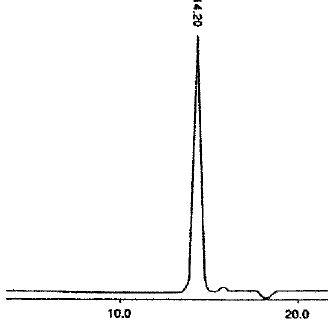
FIG. 3. HPLC profile of synthetic [l-Nal 3